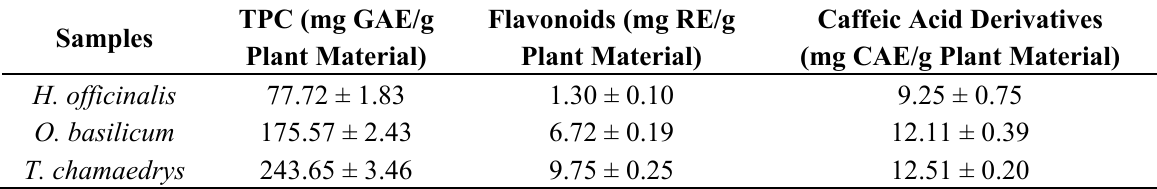
Table 2. The content of total polyphenols, flavonoids and caffeic acid derivatives in the extracts.